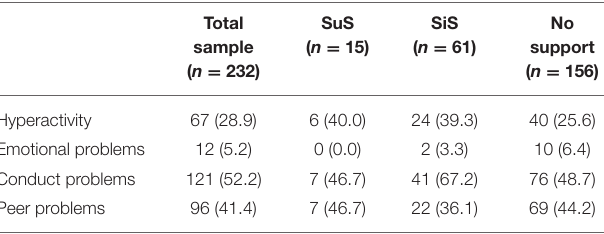
TABLE 2 | Proportion of children with behavior difficulties according to support format